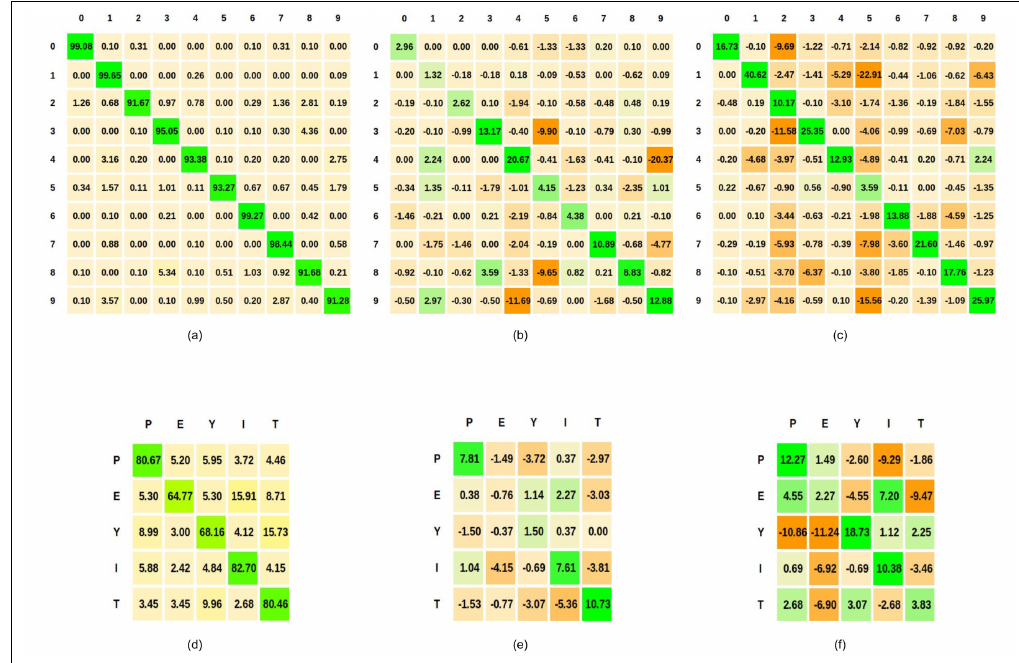
Figure 10. Written/Spoken digits confusion matrices using Hebb − Max BMU ( b ) convergence gain with respect to MNIST; ( c ) convergence gain with respect to S-MNIST; DVS/EMG hand gestures confusion matrices using Hebb − Sum All gain with respect to DVS; ( f ) convergence gain with respect to